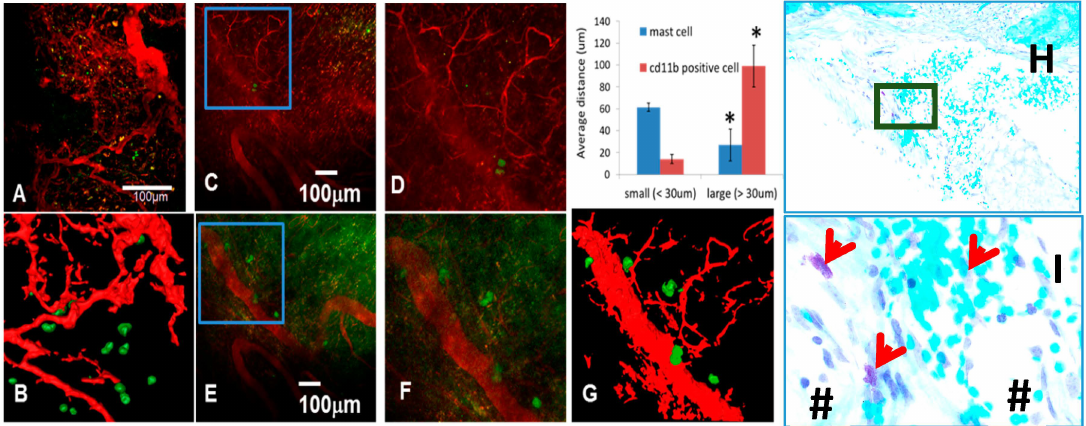
Figure 1. Mast cells accumulate proximal to large vessels in fibrotic tissue of healing critical defects. The murine chronic cranial defect window model was utilized for in vivo multiphoton laser scanning microscopy (MPLSM) to assess the temporal-spatial relationship of arteriogenesis and mast cell accumulation during critical bone defect healing. MPLSM was performed on mice ( n = 5) with cranial defect windows following administration of i.v. Texas red dextran (TRD) and APC-conjugated anti-CD11b or FITC conjugated anti-Mcpt5 antibodies. ( A ) Representative 10 ˆ field of the CD11b+ cells ( green ) and vasculature ( red ) with a 3D reconstruction ( B ); are shown to illustrate that monocytes and macrophages primarily exist proximal to small vessels within the critical defect after three weeks of healing; In contrast, few Mcpt5+ mast cells are found near small vessels (( C ); boxed region is ( D )); but appear in immediate proximity to large vessels (( E ); boxed region is ( F ) and 3D reconstructed image is ( G )); MATLAB quantification of the distance of the labeled cells from small and large vessels is presented as mean +/ ´ SD (* p < 0.05 vs. small vessels). Histologic confirmation of these findings is provided by toluidine blue staining of the calvaria tissue presented at 5 ˆ ( H ); and boxed region at 20 ˆ ( I ); in which the granulated mast cells ( red arrows) stain purple in immediate proximity to large blood vessels